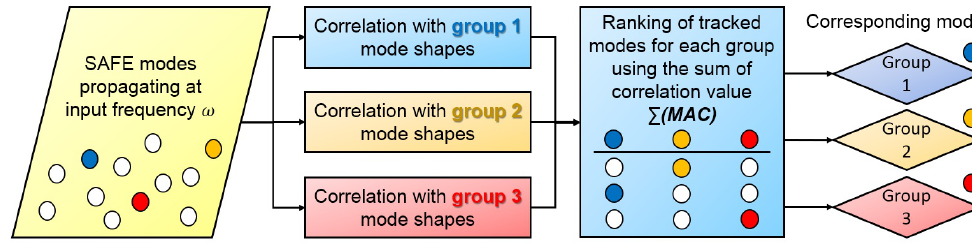
Figure 20. Representation of the mode shape tracking process that employs selected mode shape groups